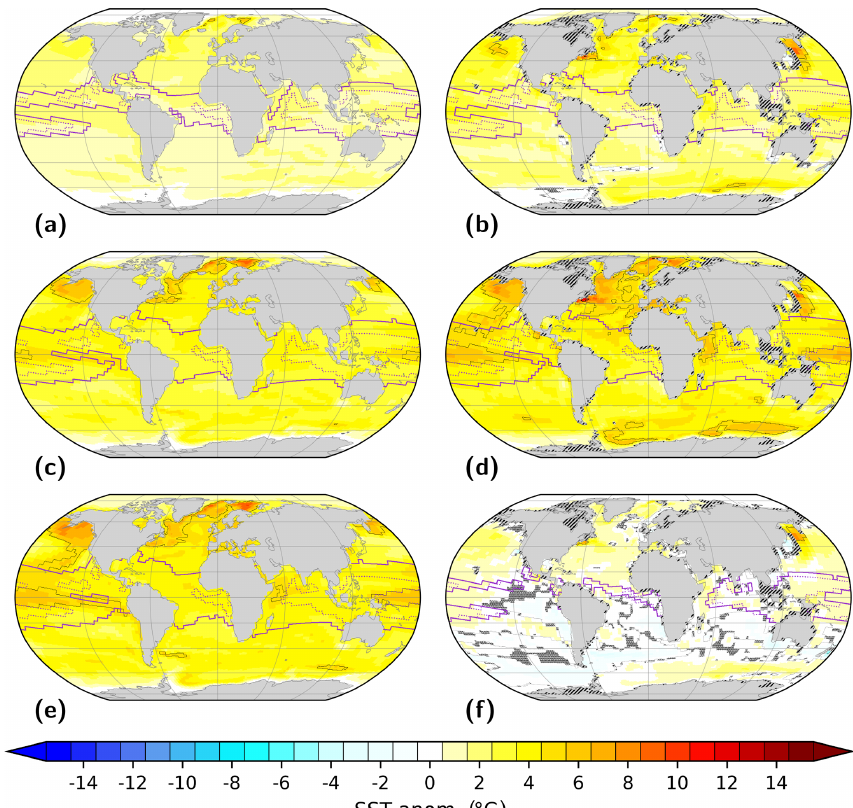
Figure 16. Annual mean sea surface temperature (SST) anomaly with respect to pre-industrial (PI, E280). We show the impact of comparable radiative forcing in setups with both modern (a, c, e) and mid-Pliocene (b, d, f) geography: (a) E400, (b) Eoi400, (c) E560, (d) Eoi560. We also show the impact of a further increased concentration of CO 2 , (e) E600, and pre-industrial CO 2 in a model setup with mid-Pliocene geography, (f) Eoi280. Light grey shading illustrates land–sea masks. In hatched ocean regions the anomaly is insignificant at the 95% confidence interval based on a t test. Hatches over land indicate differences in land–sea configuration between a specific simulation and the PI reference. Black contours illustrate isotherms of 0 ◦ C (dotted, thin), 5 ◦ C (solid, thin), and 10 ◦ C (solid, thick). The extent of the equatorial warm pool, defined as regions above 28 ◦ C, is indicated by violet contours for PI (dotted) and for a specific simulation (solid). We define SST as the temperature of the uppermost ocean layer centred around a depth of